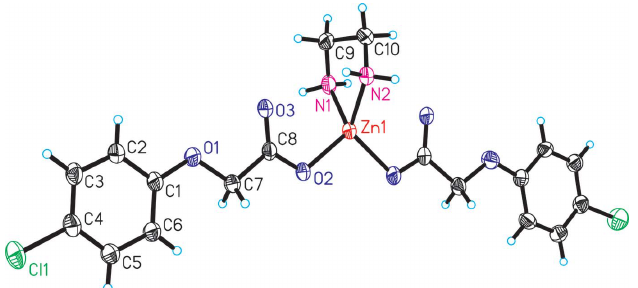
Figure 1 The molecular structure of the title compound, with displacement ellipsoids drawn at the 30% probability level. Unlabelled atoms of the second cCPA ligand are related to the first by a prime character but are not crystallographically